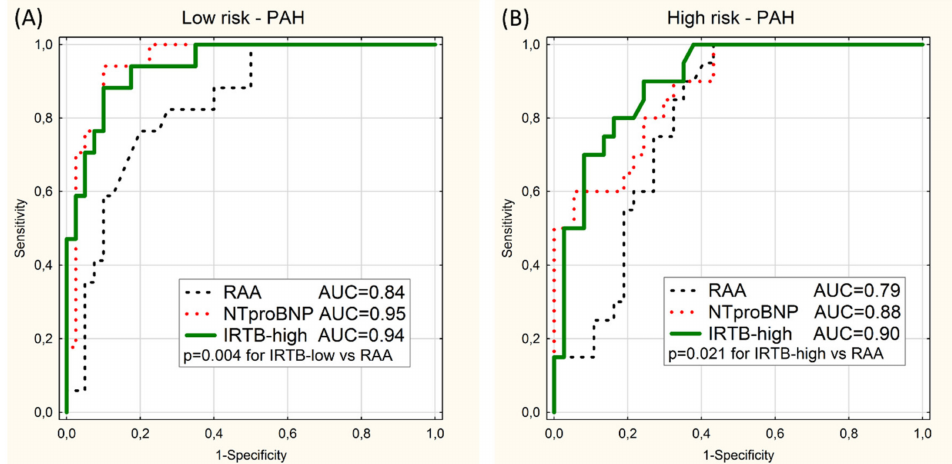
Figure 3. ROC curves for prediction of the low-risk category ( A ) and the high-risk category ( B ) in the PAH subgroup using 2 univariable models (RAA and NTproBNP) and the multivariable model (IRTB-low or IRTB-high). Values of area under curves (AUC) and significant p -values ( p ) are presented.